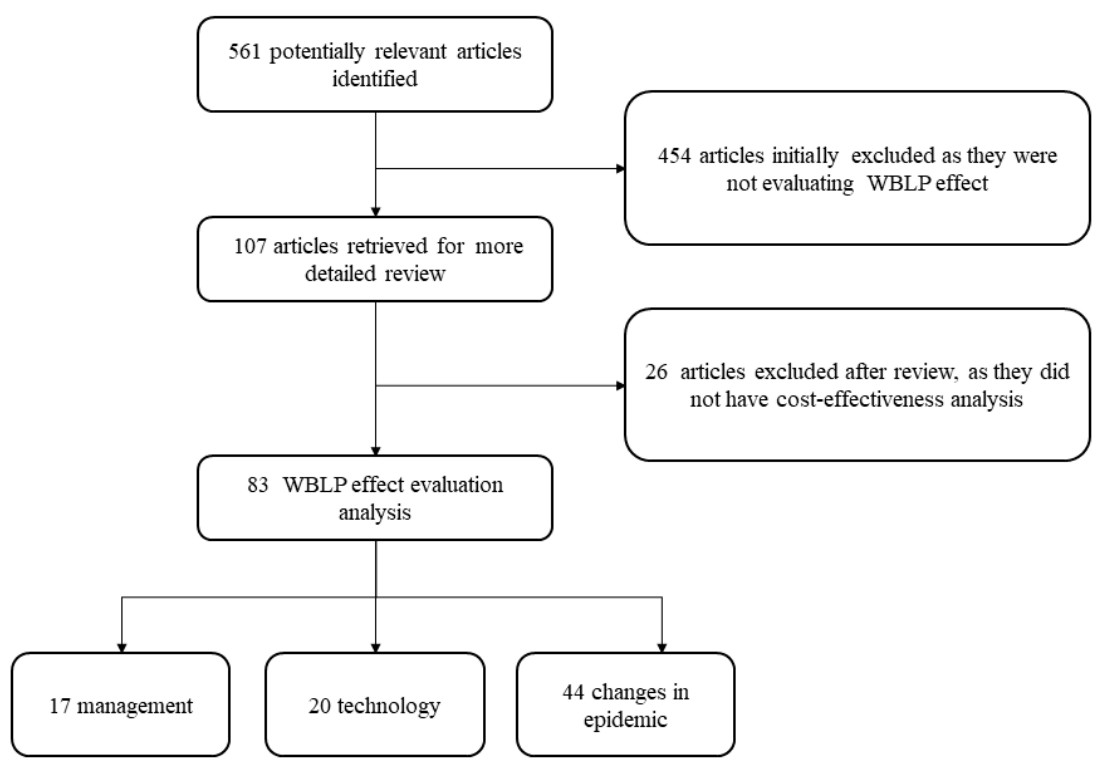
Figure 2. Flow chart to identify studies with relevant information for determining the short-, mid-, and long-term effects of the 10-year World Bank Loan Project (WBLP) for schistosomiasis control in the People’s Republic of China.